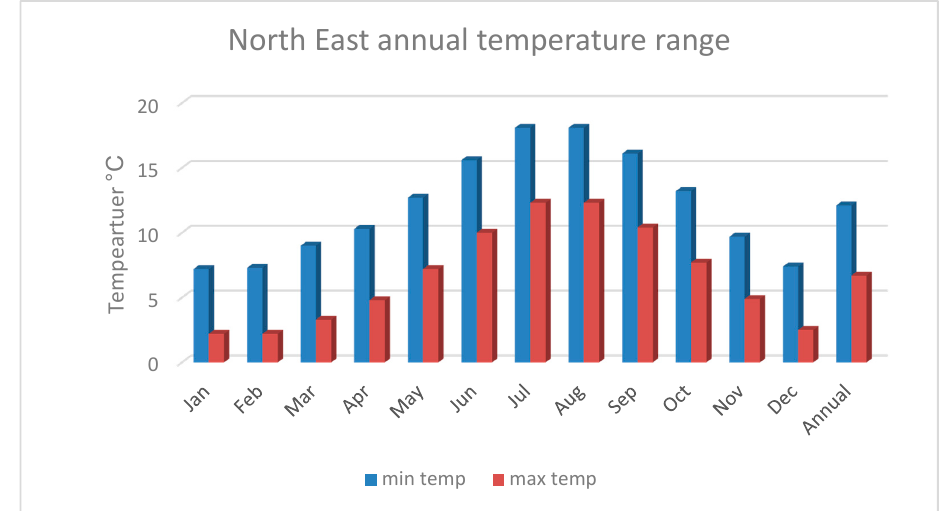
Figure 3. North east England temperatures (2014) and average temperature for Gateshead (2000–2012), data from [36,37].